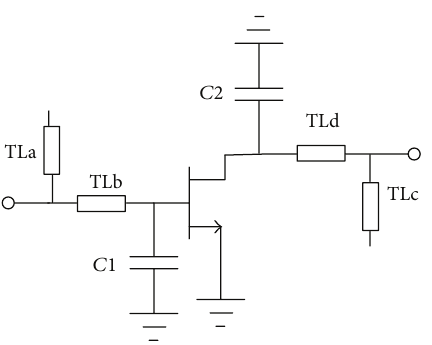
Figure 3: The multiharmonic prematching network for the 4 × 65 𝜇 m pHEMT cell.